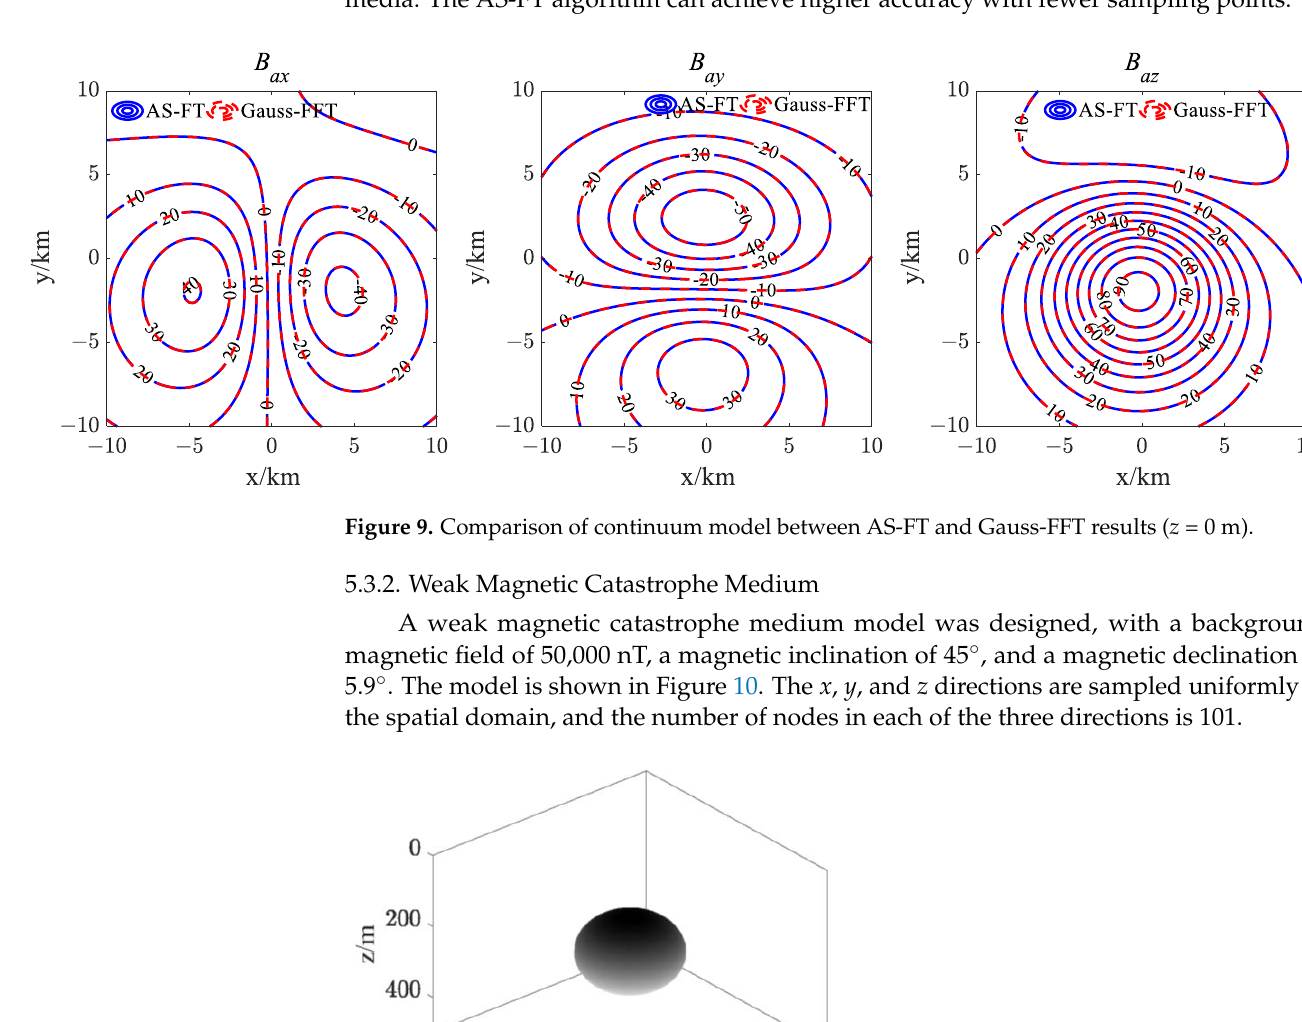
Figure 9. Comparison of continuum model between AS-FT and Gauss-FFT results ( z = 0 m).